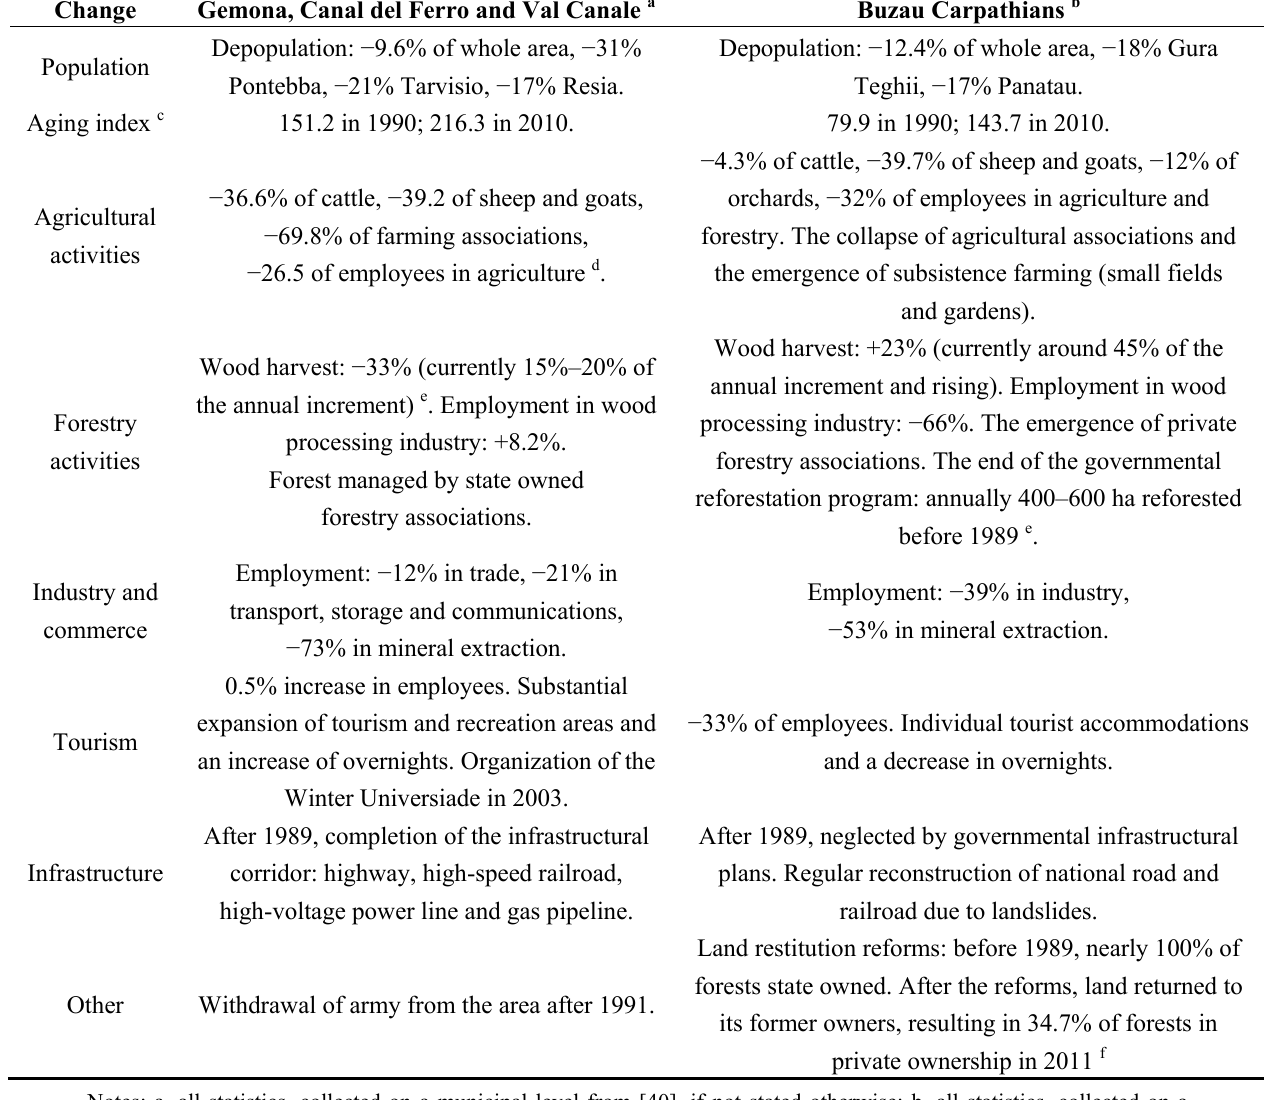
Table 7. Socio-economic changes in the areas since